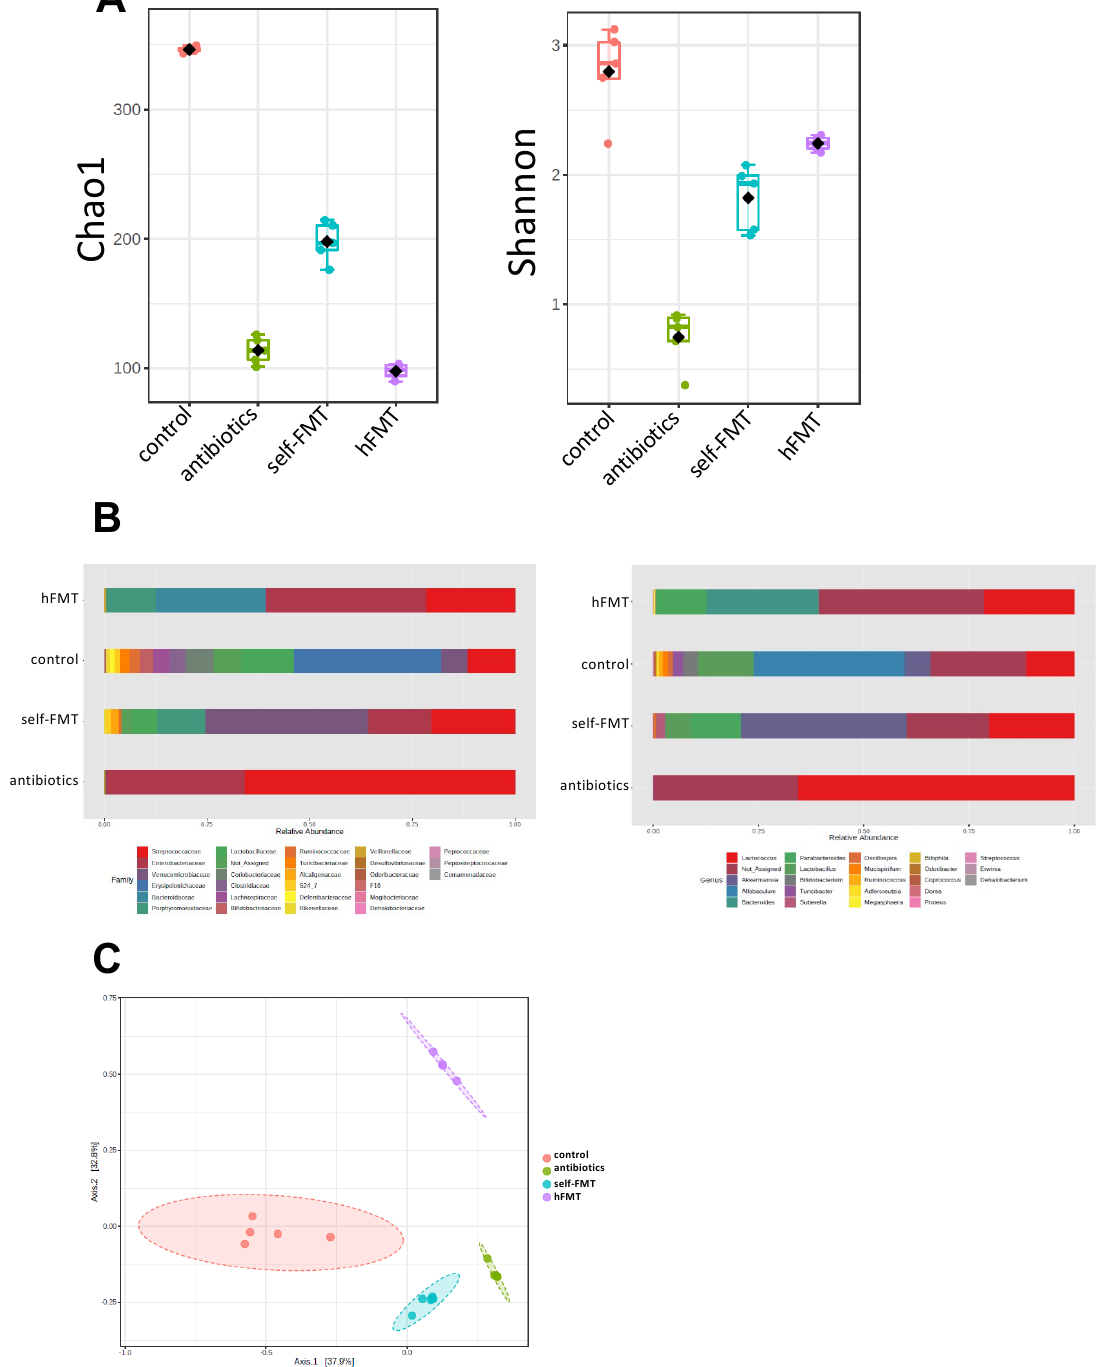
Figure 3. Changes in intestinal bacterial composition in the mice groups. ( A ) Microbial α -diversity. Microbial richness (Chao1) and diversity (Shannon) indexes are shown. ( B ) Relative abundance of bacterial taxa (family and genus levels) found in the feces of the different mice groups. ( C ) Differences in microbial global composition after the different treatments. A principal coordinate analysis (PCoA) of the Bray-Curtis dissimilarity indexes of samples is shown (PERMANOVA F-value = 36.77; R 2 = 0.8803; p <